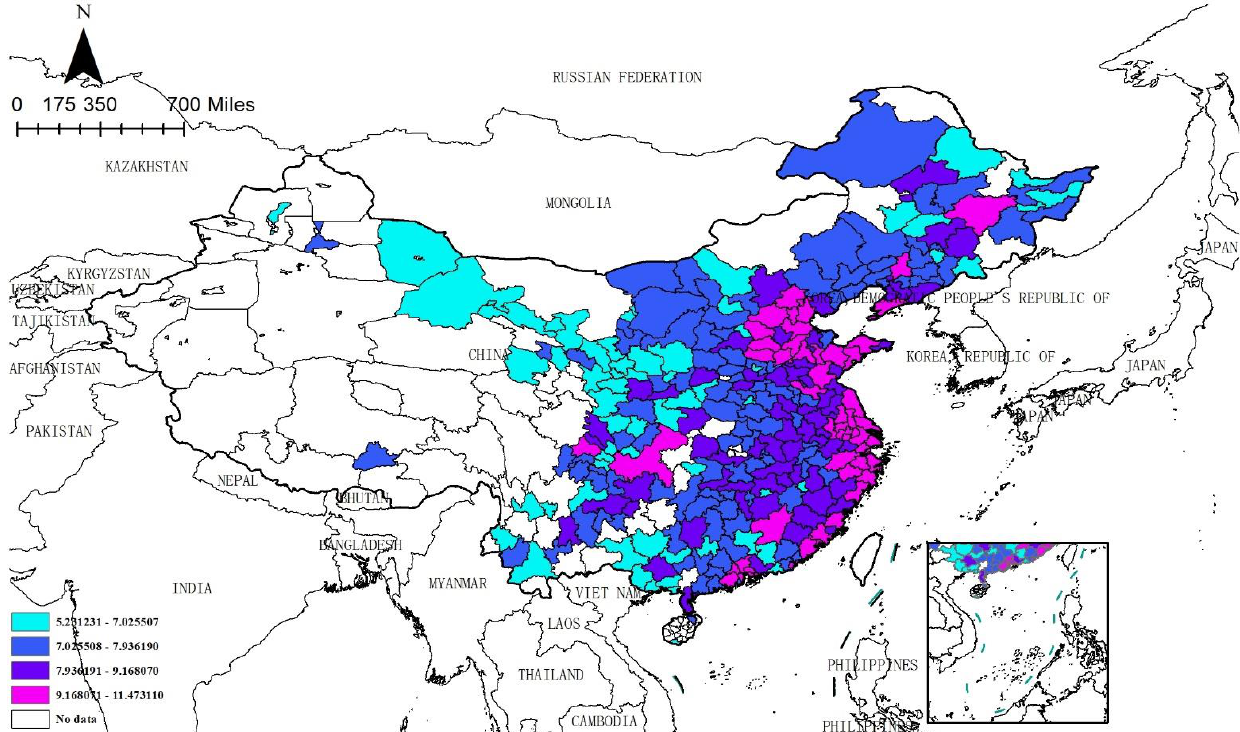
Figure 3. Enterprises Distribution. Note: The arithmetic mean values of the enterprises’ site selection (2014–2020) is adopted.